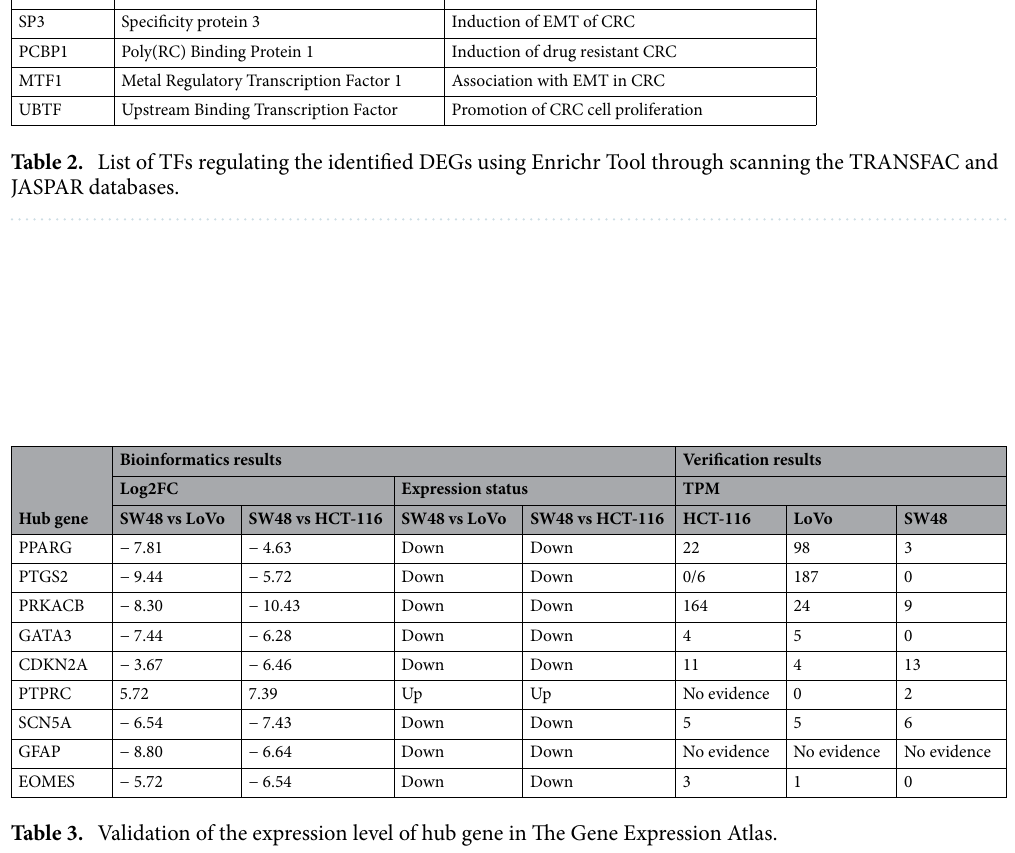
Table 3. Validation of the expression level of hub gene in The Gene Expression Atlas.